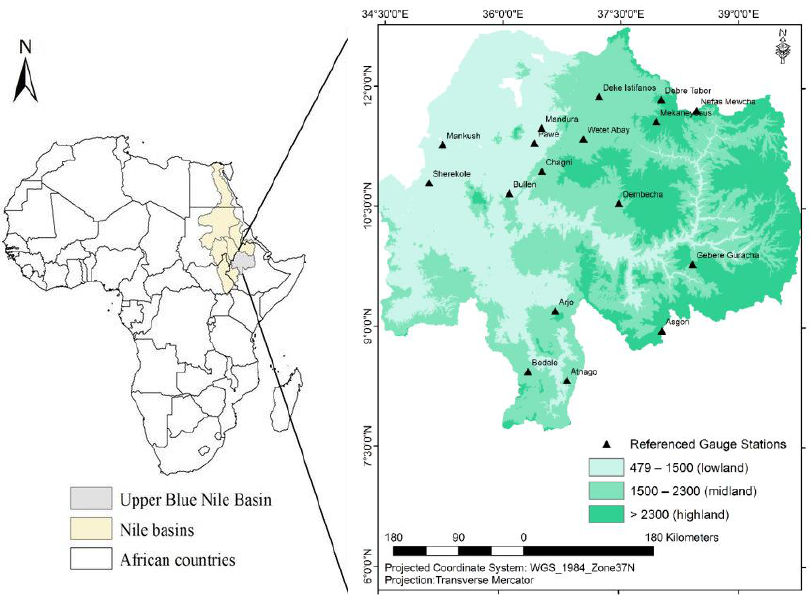
Figure 1. Location map of the Upper Blue Nile basin, Ethiopia.